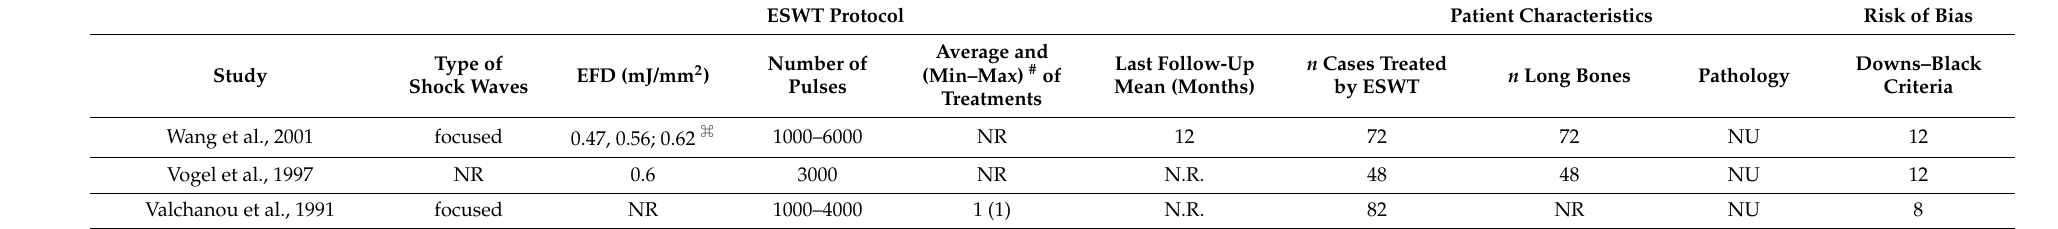
Table 1. ESWT protocol, patient characteristics, and risk of bias of included studies. EFD = energy flux density, NR = not reported, NU = nonunion, DU = delayed union, * 3000–4000 pulses applied to femur, tibia, fibula, humerus; 2000–3000 pulses applied to other, smaller bones, ** 6000–10,000 pulses applied to femur and tibia; 4000 pulses applied to humerus; 3000 pulses applied to radius and ulna, 6000 pulses applied to femur and tibia; 3000 pulses applied to humerus; 2000 pulses (group 2), ◊ 0.56 for humerus, radius, ulna; 0.62 for femur and tibia; ⌘ 0.47 for MT; 0.56 applied to radius and ulna; 1000 pulses applied to MT, # 0.4 (group 1)–0.7 for humerus, radius, ulna; 0.62 for femur and